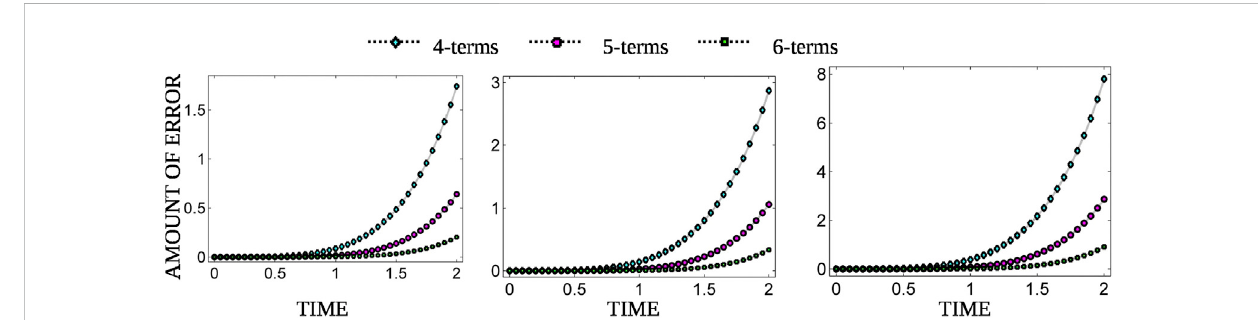
FIGURE 2 Error estimations for the molding process at β = 1 and x = 0.5, 1,